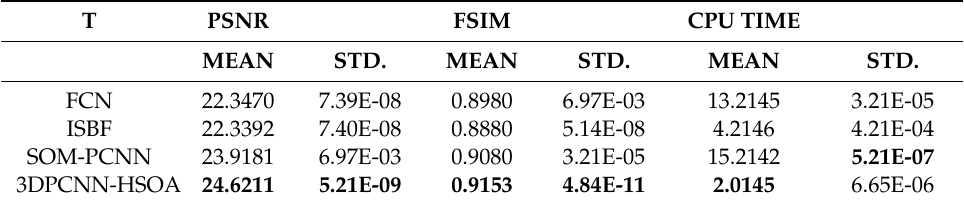
Table 5. The result of the compared satellite image segmentation method. T PSNR